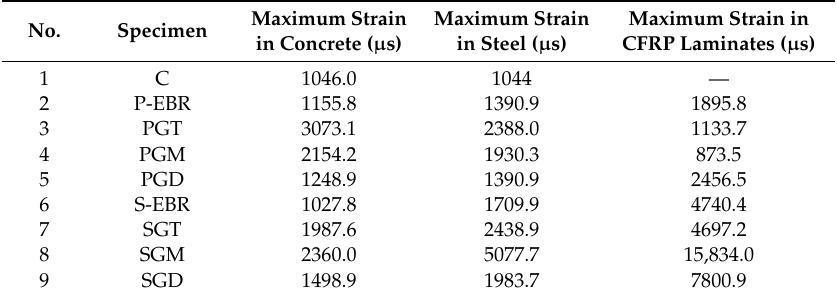
Table 4. Summary of experimental results.